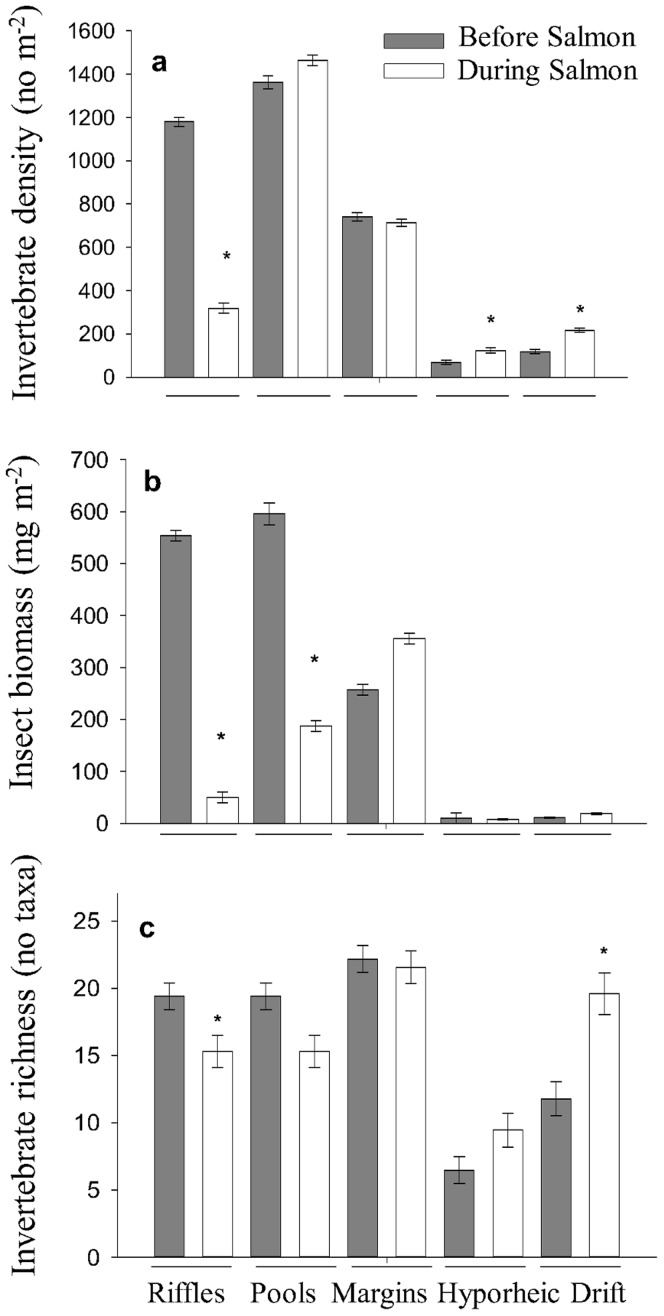
Invertebrates in all habitats before and during spawning.Invertebrate density (a), insect biomass (b) and taxonomic richness (c) before (dark grey bars) and during (white bars) the salmon run in riffles, pools, margins, the hyporheic zone, and drift. Graphs shows +/−1 s.e. and * means p<0.05.